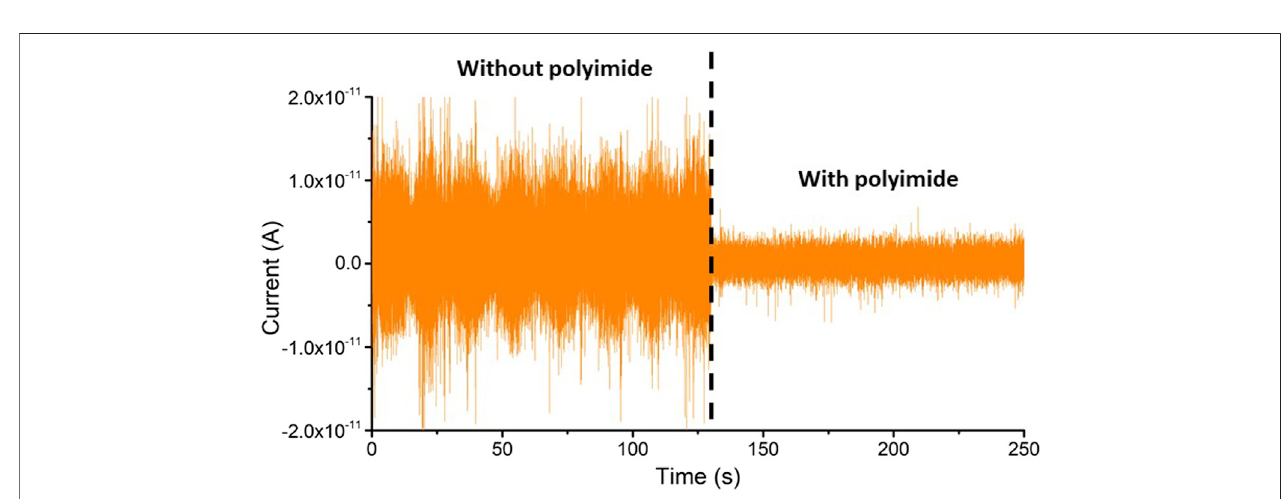
FIGURE3| CurrentleakagemeasurementofPDMS/SEGbackelectrode (left) andPDMSwithablockinglayerofpolyimide – PDMS/polyimide/SEG (right) withan applied voltage of 40 V across the device.